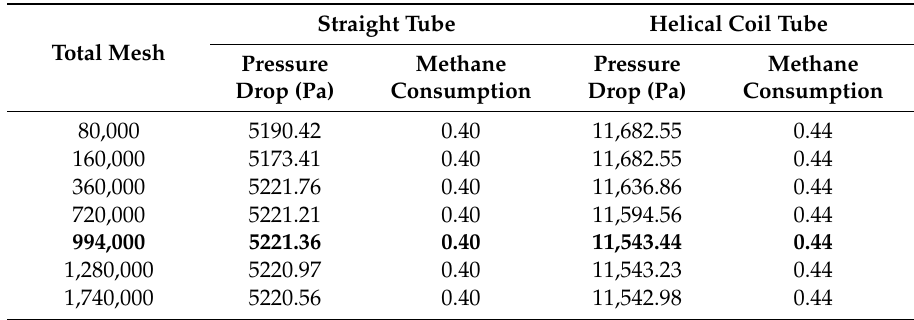
Table 4. Example of a mesh independent test for square cross-section. The mesh used is highlighted in